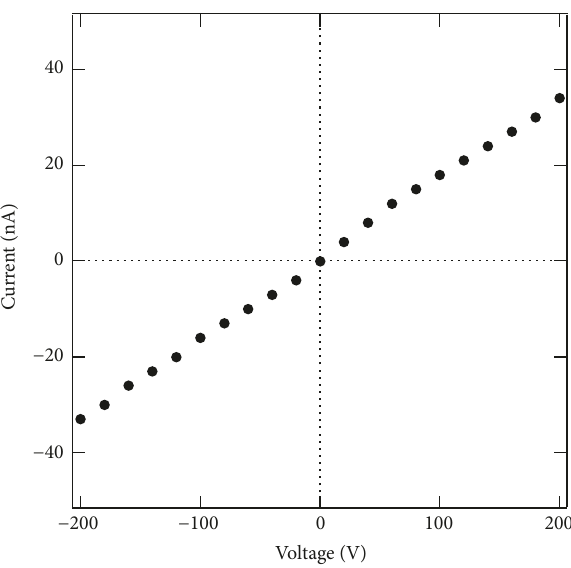
Figure 7: Current–voltage characteristics of an SbI 3 detector at room temperature.